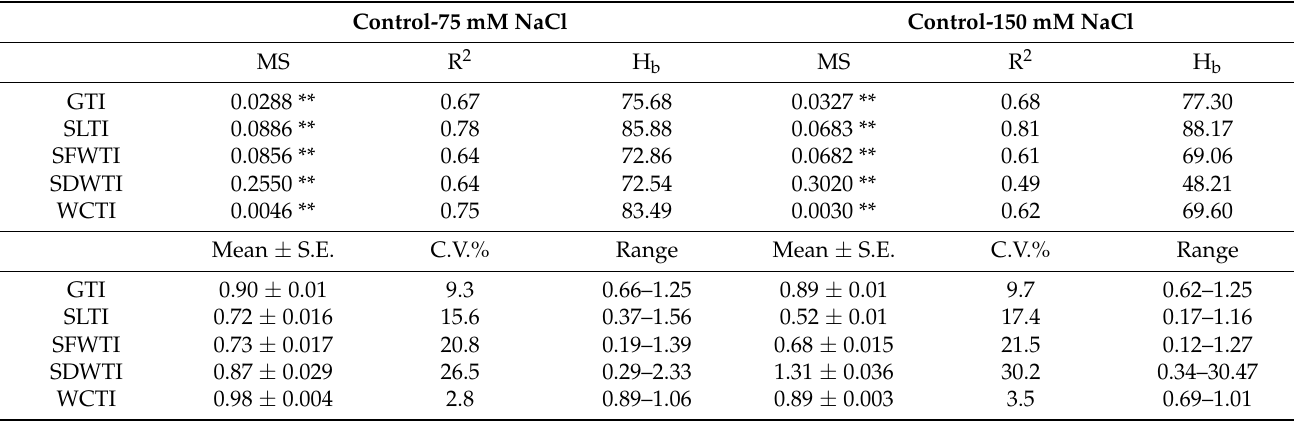
Table 3. Mean squares (MS), coefficient of determination (R 2 ), and broad-sense heritability (H b ), means ± standard error (S.E.), coefficient of variation (C.V.%), and range for five salinity tolerance indices related to germination and seedling traits as comparison between control and salinity